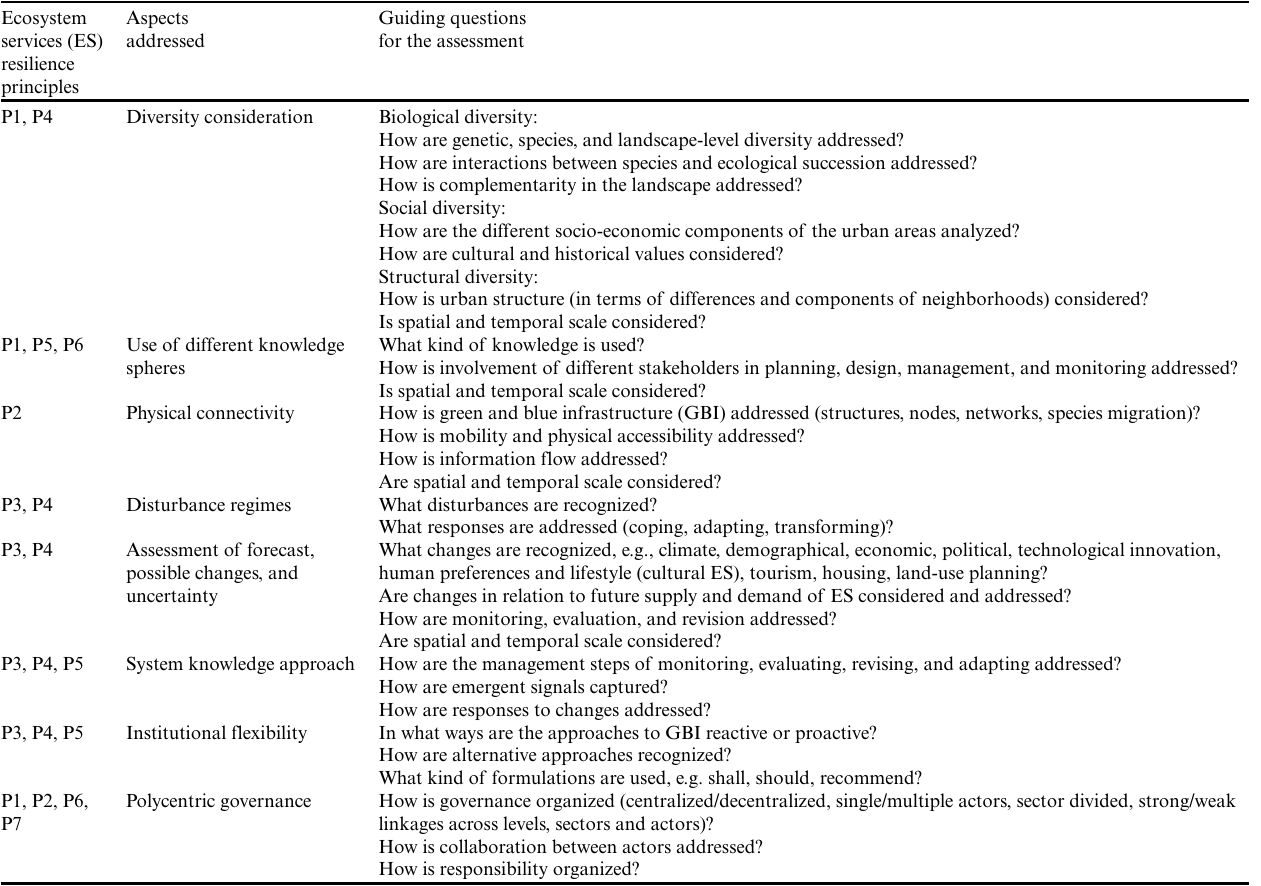
Table 1. Urban ecosystem services resilience assessment matrix (based on Biggs et al. 2012, Borgström et al. 2015, and Nykvist et al. 2017). Ecosystem services